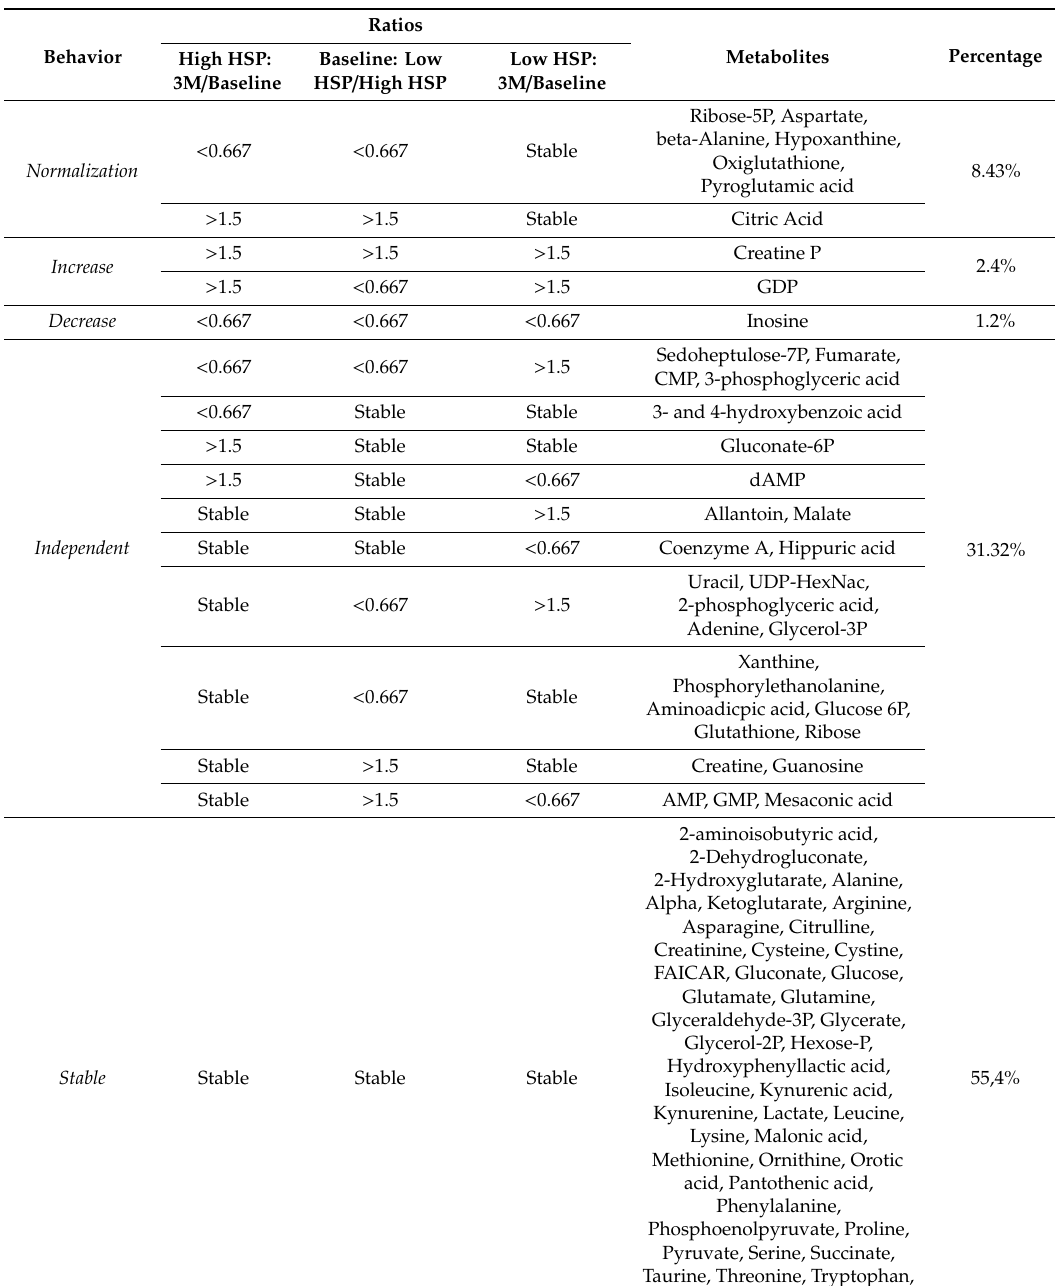
Table 3. Clustering of metabolites sharing similar behavior. Ratios between the pooled metabolites of high HSP27 at baseline and 3-month follow-up (high HSP: 3M / baseline), low HSP27 at baseline and 3-month follow-up (low HSP: 3M / baseline) and high HSP27 and low HSP27 at baseline (baseline: low HSP / high HSP) are clustered on behavior. Ratios between 0.667 and 1.5 are classified as